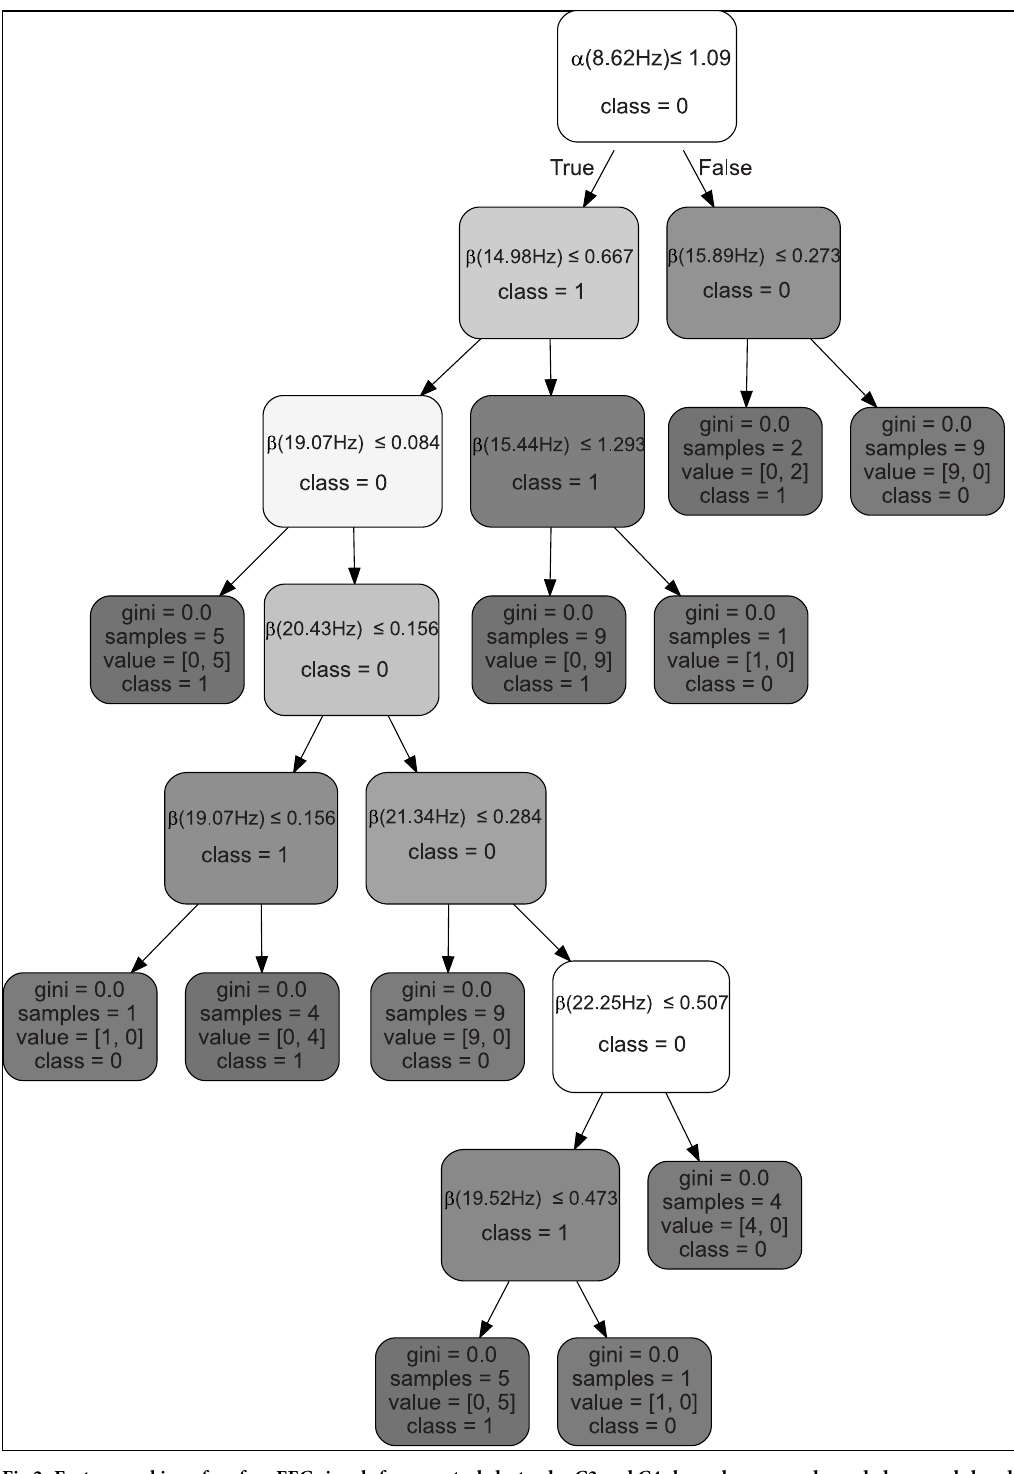
Fig 2. Feature ranking of surface EEG signals from central electrodes C3 and C4 showed accuracy depended on α sub-band 8.62 Hz and β sub-bands 14, 15, 19, 20, 21, 22 Hz while classifying movement (gray) against premovement (light grey/ white) class labels (Class 0 is premovement, Class 1 is grasped